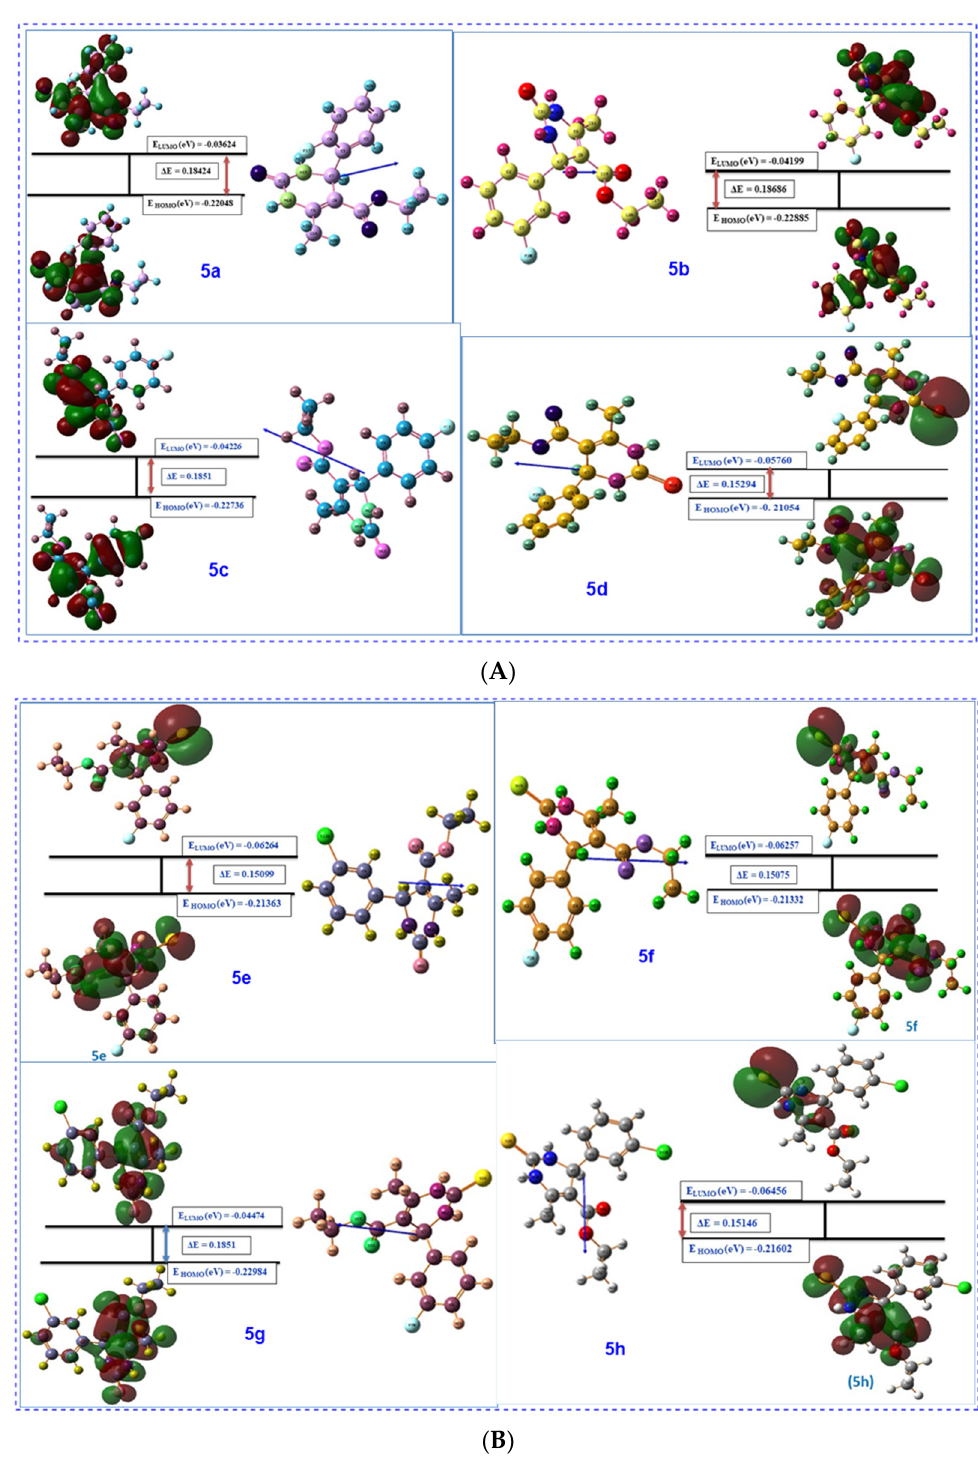
Figure 14. ( A ) Contour diagrams of FMOs comprising the highest occupied molecular orbitals (HOMO) and the lowest unoccupied molecular orbitals (LUMO), along with energy gap ( ∆ E), optimized geometry of structures with numbering system and the vector of the dipole moment for compounds 5a – d . ( B ) Contour diagrams of FMOs comprising the highest occupied molecular orbitals (HOMO) and the lowest unoccupied molecular orbitals (LUMO), along with energy gap ( ∆ E), optimized geometry of structures along with numbering system and the vector of the dipole moment for compounds 5e – h